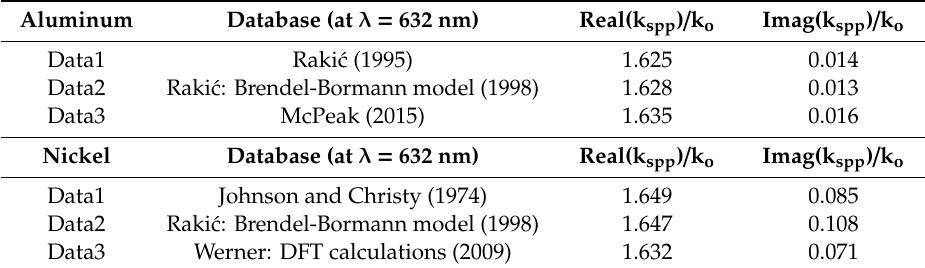
Table 1. Computed k spp values on Al film and Ni film from various data bases. The database values could be found in [45].